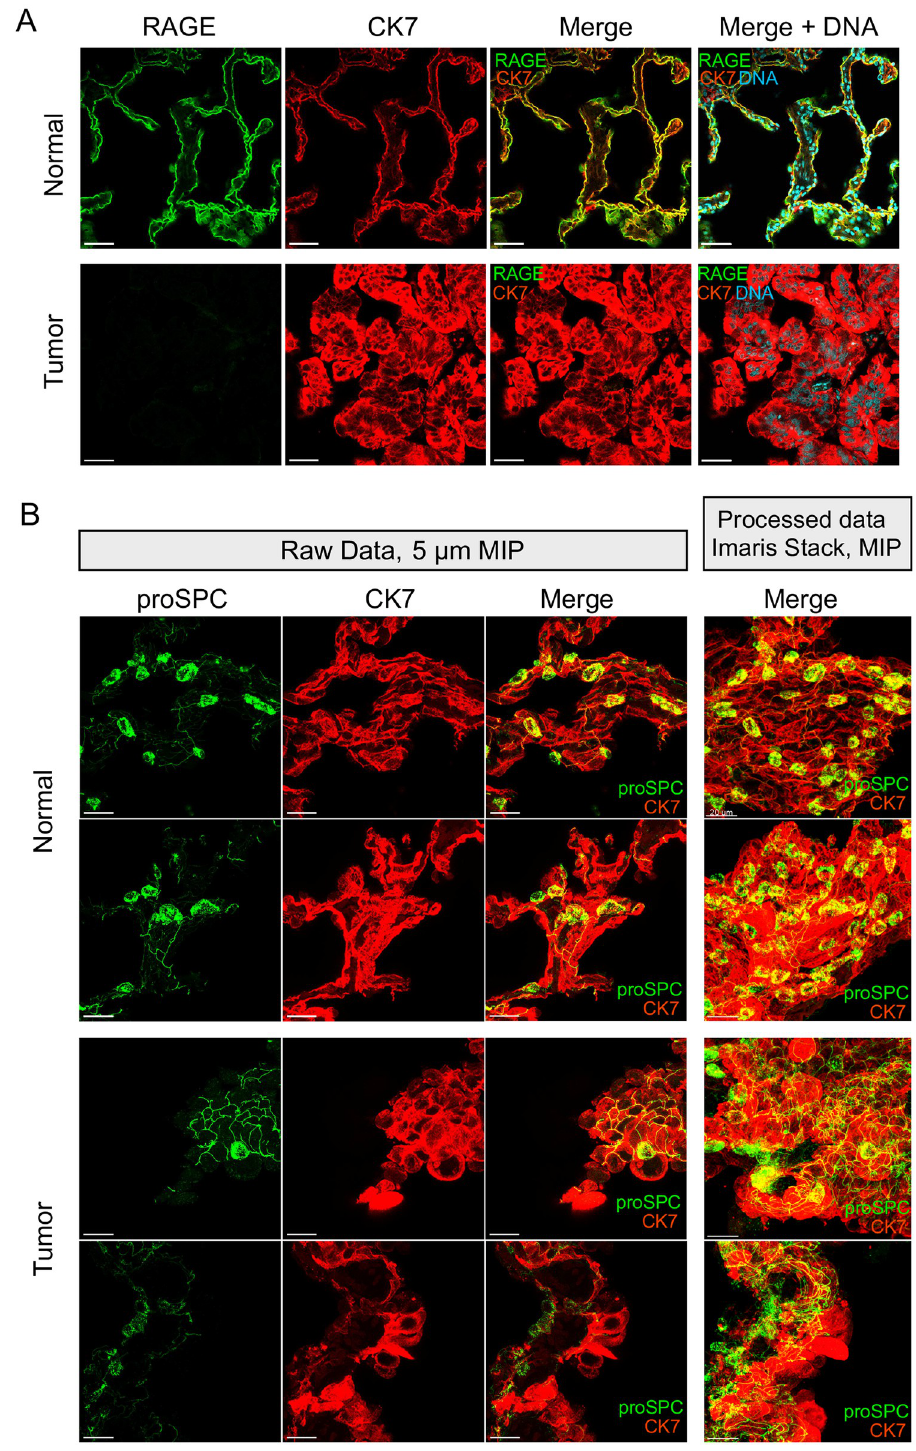
Fig 6. AT2-like cells display cellular processes whose organization is altered in lung adenocarcinoma. A., 25X images at 0.3779 μ m resolution showing a single plane display RAGE, (green) is expressed highly in AT1 cells in normal tissue, top, but we could not detect expression in either genotype of tumor cells bottom. KRAS+ shown. Cells immunostained for CK7 (red) and DNA (cyan). B., 63X images shown. Left three columns, raw data shown in a maximum-intensity projection (MIP) 5 μ m thick illustrates the behavior of the AT2 process network in normal distant